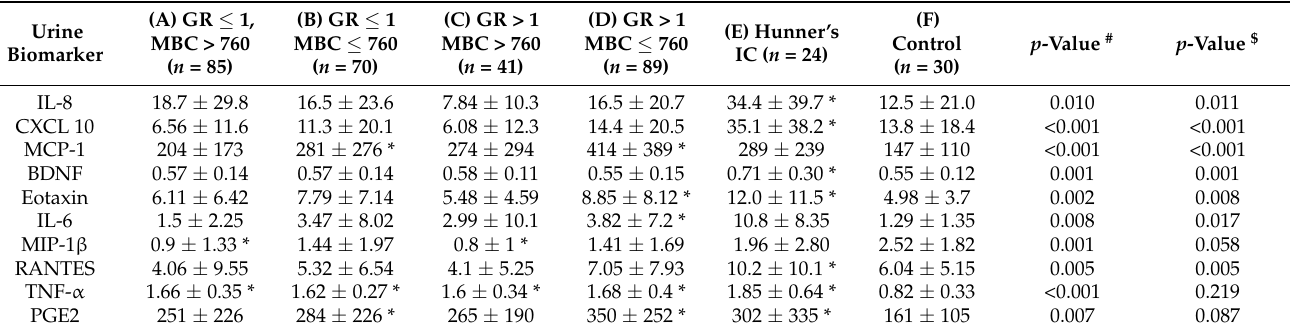
Table 4. Urinary biomarkers in overall patients with interstitial cystitis/bladder pain syndrome with different subtypes and controls.